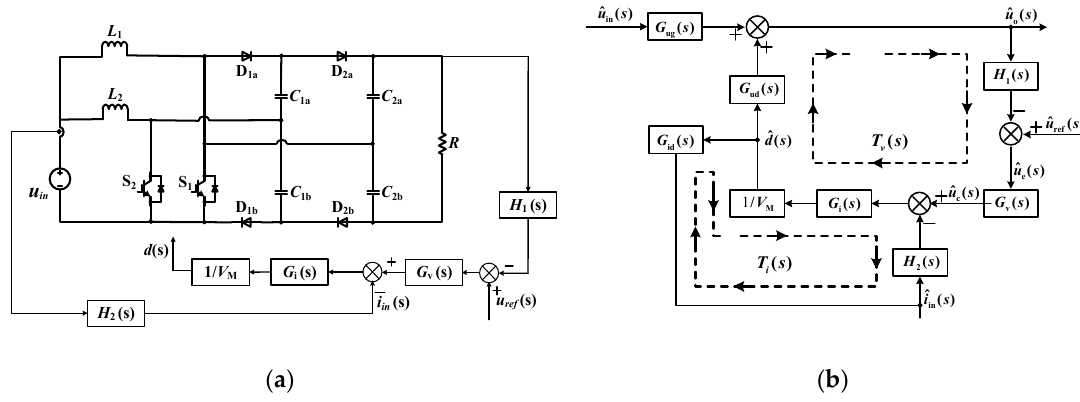
Figure 10. Voltage control system: ( a ) for converter circuit with 2 VMs; ( b ) control schematic diagram. The voltage loop gain is affected by the current loop gain, so the design of the current loop compensator needs to be completed first. The current loop gain without the current loop compensator G i (s) can be obtained by (18) as T i-e (s).